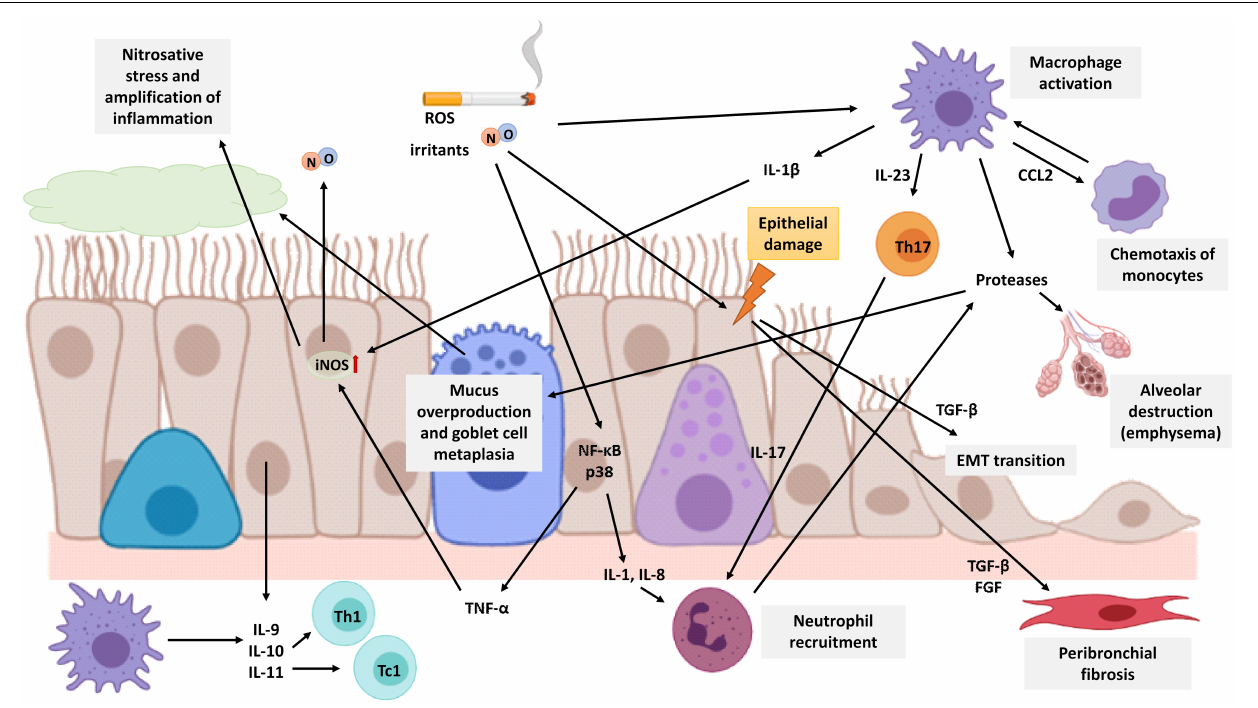
FIGURE 4 | Schematic representation of lung neutrophilic inflammation characteristic of COPD. Cigarette smoke is a source of exogenous NO, irritants, and ROS that activates macrophages and epithelial cells of the airways to release cytokines that attract inflammatory cells to the lungs. Macrophages secrete CCL2 to attract monocytes which differentiate into macrophages in the lungs. Epithelial cells secrete IL-1 and IL-8 to attract neutrophils, and both macrophages and epithelial cells secrete IL-9, IL-10, and IL-11 to attract Th1 cells and Tc1 cells. In addition, macrophages also release IL-23 triggering Th17 cell activation which in turn promotes neutrophilic inflammation by producing IL-17. Neutrophils, macrophages, and epithelial cells release proteases, such as MMP-9, which cause alveolar destruction, emphysema, mucus overproduction, and goblet cell metaplasia. Cigarette smoke causes epithelial damage that triggers the epithelial cell secretion of TGF- β , among other growth factors, which stimulates fibroblast proliferation and EMT, resulting in airway remodeling and fibrosis around the small airways. The expression of the iNOS enzyme is increased in epithelial cells by TNF- α and IL-1 β produced by epithelial cells and macrophages, respectively. Increased NO levels are associated with epithelial-cell-derived nitrosative stress, which causes oxidation and tyrosine nitration of several lung proteins generating an amplification of the inflammatory response. The image has been created with